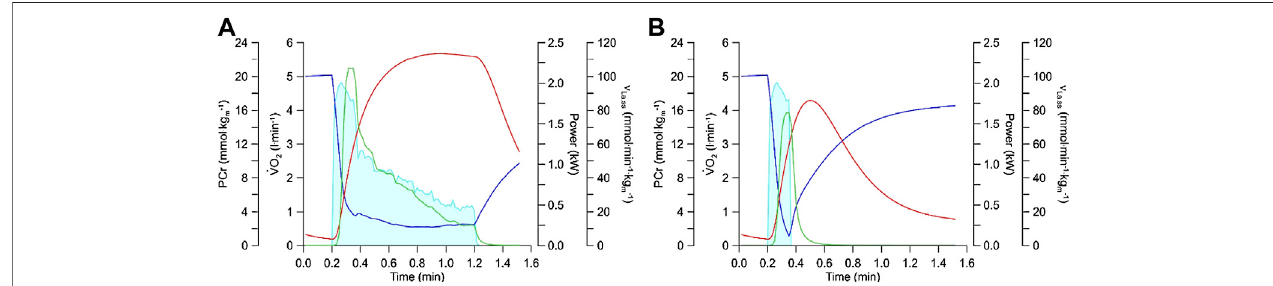
FIGURE 6 | (A) Simulation of energy metabolism during a 1,000 m time trial of a track cyclist. This calculation is based on the recorded power output from an Olympic track cyclist using theequations from theMader model, thecomputersimulationcalculatesthebehaviorofglycolytic fl ux (green line;expressed per kg muscle), PCr levels (blue line), and oxygen uptake (red line) in dependency of the power output (light blue shade). Physiological variables used in the simulation were _ VO 2max : 65 ml min − 1 kg − 1 ; ν La.max : 0.9 mmol . L − 1 s − 1 ; bodyweight: 95 kg; and active muscle mass: 40%. (B) Simulation of energy metabolism for the power output during the 1,000 m time trial as conducted by the athlete in Panel 6A but possessing a lower maximal glycolytic rate. The input parameters were _ VO 2max : 65 ml min − 1 kg − 1 ; ν . L − 1 s − 1 ; bodyweight: 95 kg; and active muscle mass: La.max : 0.4 mmol